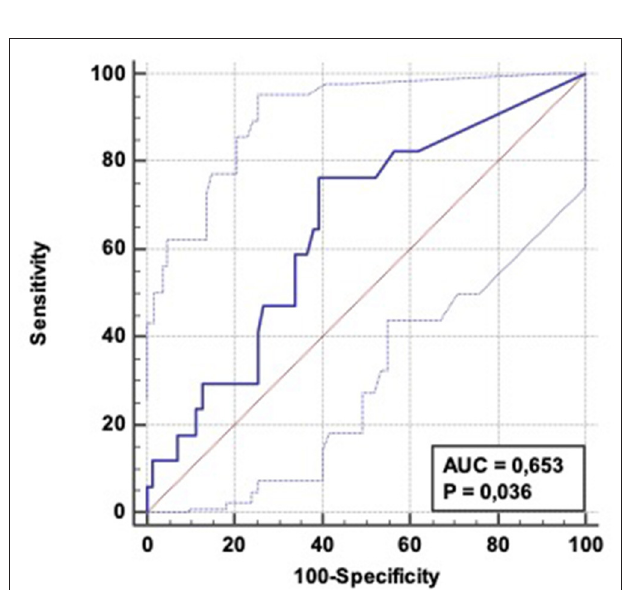
FIGURE 4 | ROC curve: Diagnostic ability of α -amylase level to predict aspiration pneumonia occurrence within 48h following OHCA admission. AUC = 0.653 (CI 95%: 0.524–0.0.785) ; Positive LR = 1.94 (CI 95%: 1.3–2.9) ; Negative LR = 0.39 (CI 95 %: